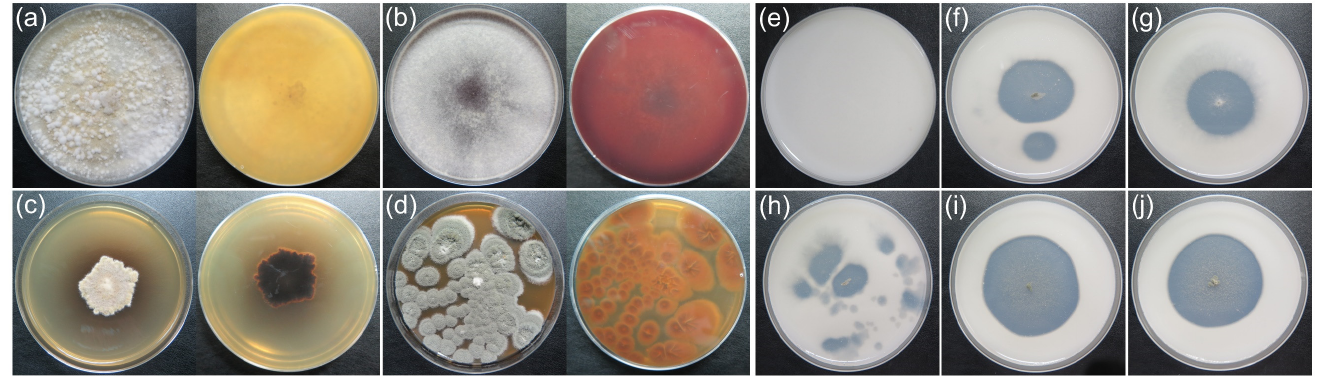
Figure 8. Fungal pigment secretion (day 15, Czapek-Dox) and the phenomenon of calcite dissolution (day 20, CaCO 3 glucose agar) in a medium. ( a ) O. cfr. artemisiae ; ( b ) C. cfr. luteum ; ( c ) E. cfr. nigrum ; ( d,f ) P. cfr. chrysogenum ; ( e ) transparent non-inoculated plate; ( g ) C. cfr. sphaerospermum ; ( h ) Penicillium sp.; ( i ) P. cfr. citrinum ; ( j ) P. cfr. rubens .